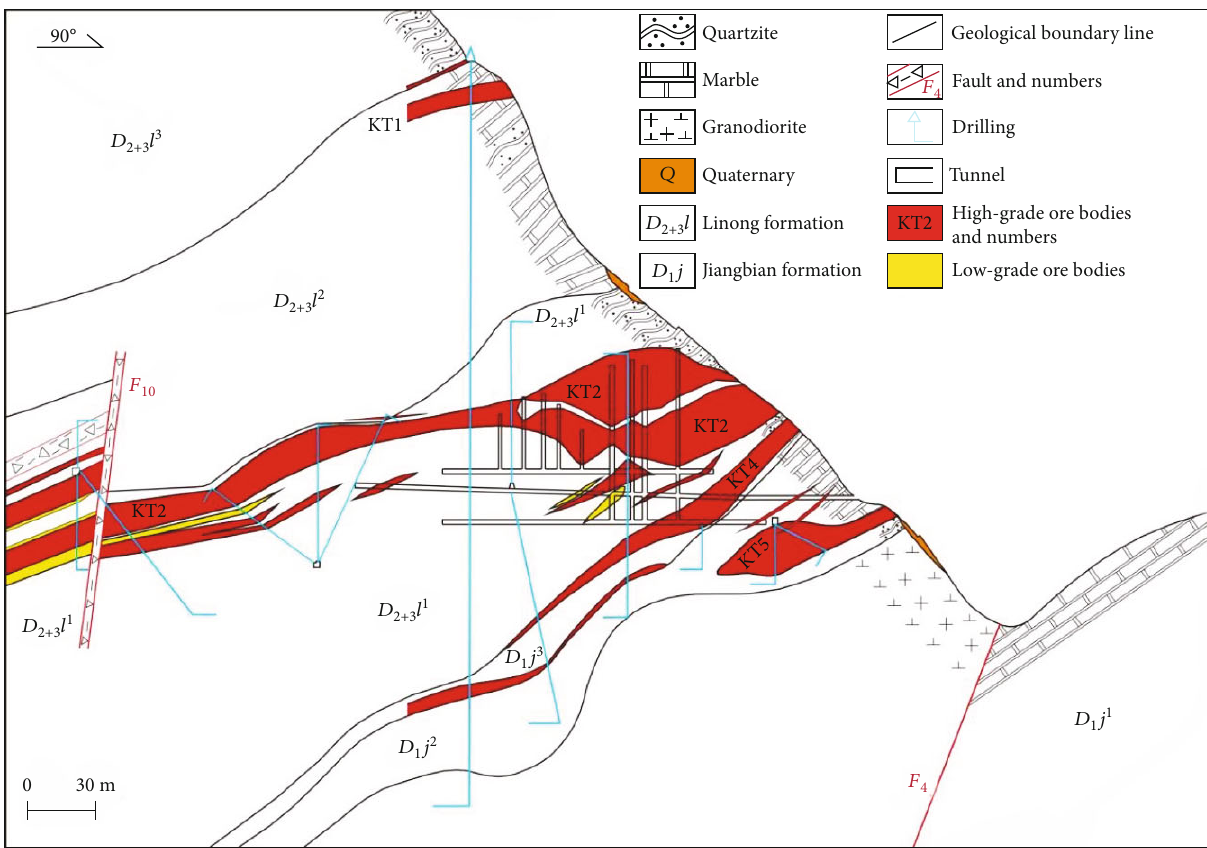
Figure 2: The no. 25 prospecting line pro fi le map in Yangla copper deposit, Yunnan, China (after Reference